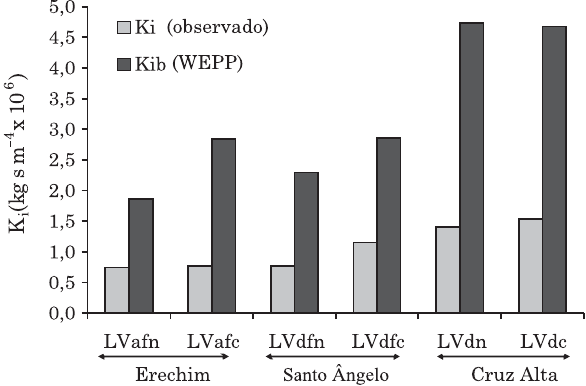
Figura 1. Fator de erodibilidade do solo em entressulcos observado (K ) e estimado pelo uso i ) utilizado no da textura (Alberts et al., 1995) (K ib modelo WEPP; LVaf = Latossolo Vermelho aluminoférrico; LVdf = Latossolo Vermelho distroférrico; LVd = Latossolo Vermelho distrófico; n = natural; c = cultivado.